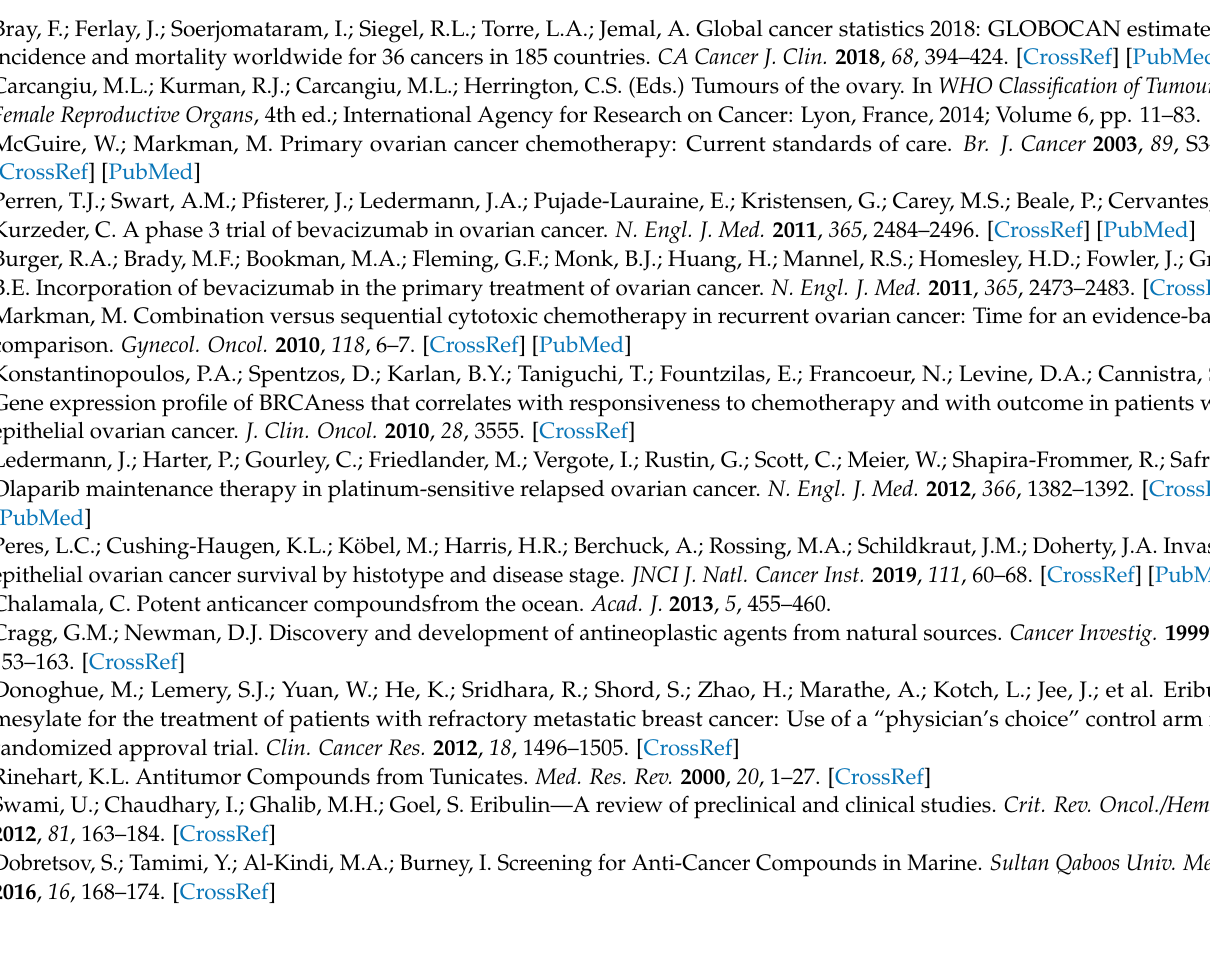
Supplementary Materials: Figure S1: Total proteins load by Coomassie brilliant blue staining of SDS-polyacrylamide gel. Different protein lysates from cancer cells (50 mg/mL) were loaded